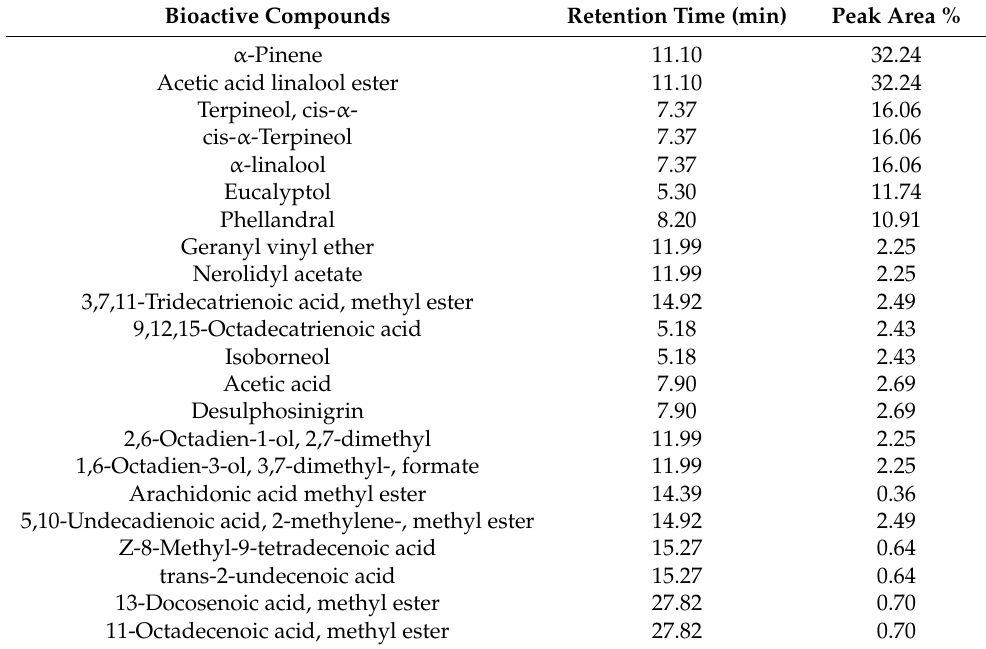
Table 2. The main compounds identified in LEO by GC-MS